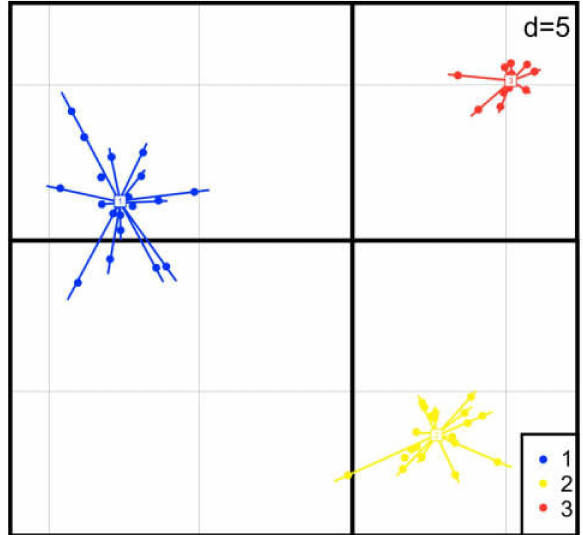
Figure 2. Discriminant analysis of principal components in nine loci and three populations of O. drummondii . The axes represent the first two linear discriminants (LDs). Numbers represent populations: 1 = Altamira (native, blue), 2 = La Mancha (native, yellow), and 3 = El Dique (invasive, red). Lines represent the genetic variation within populations, dots represent the 360 genotypes, and d represents the grid’s